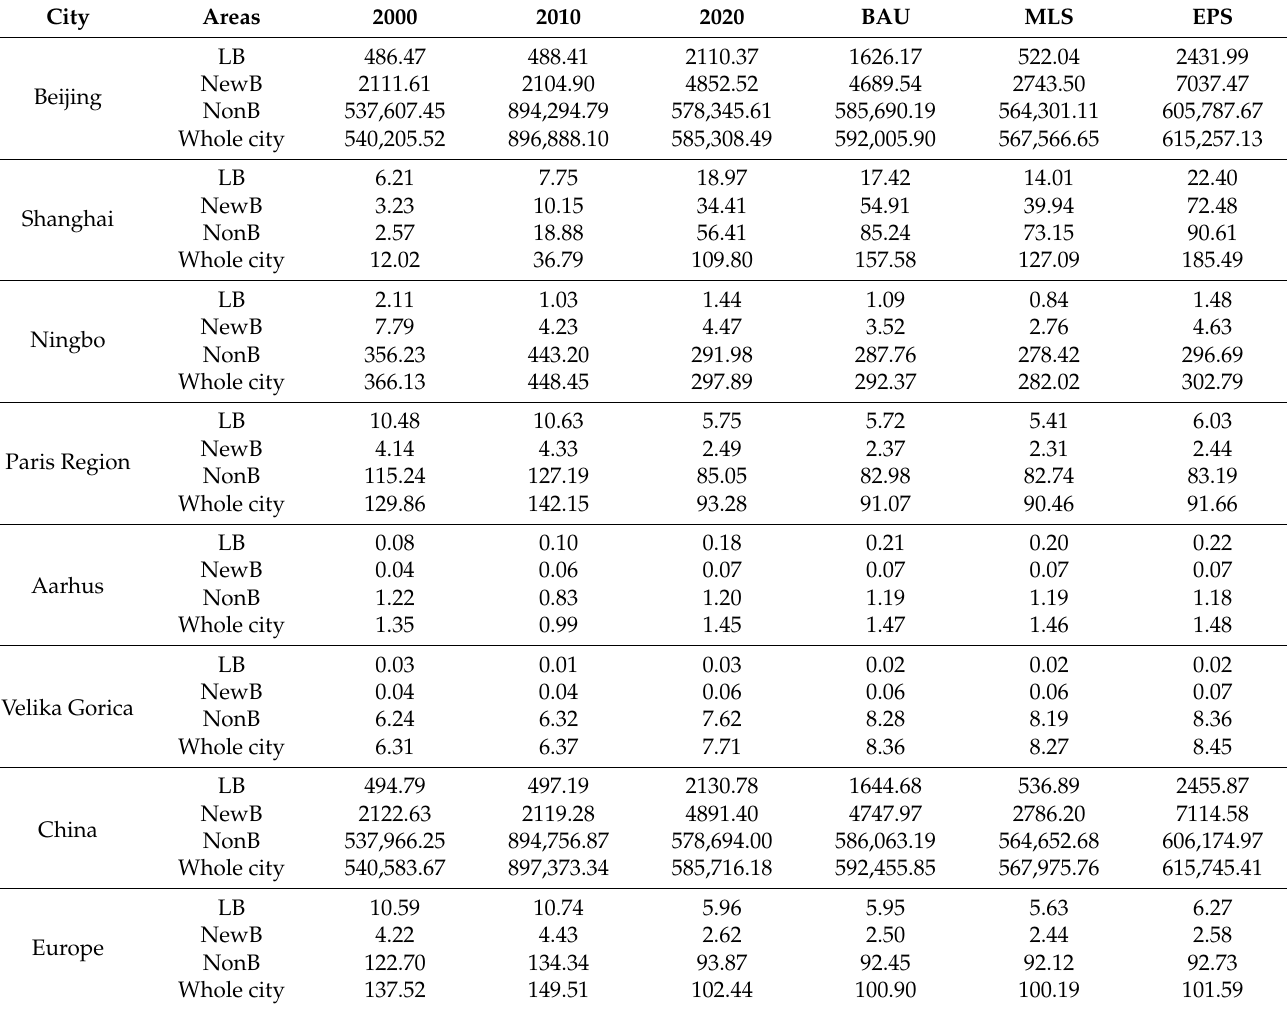
Table A7. Total carbon storage statistics for different areas of each city from 2000 to 2030. (Unit: 10 2